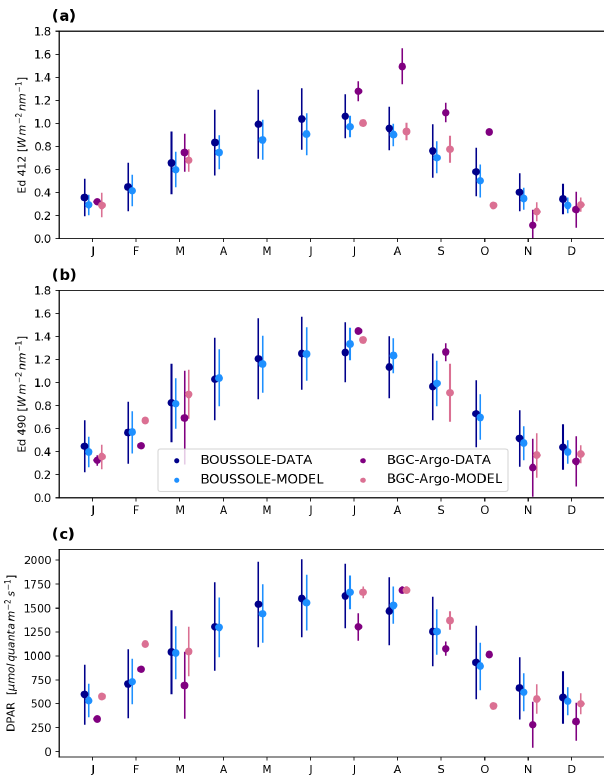
Figure 13. Scatter plots of the climatological monthly mean values and standard deviations of the downward ir- radiance E d (λ = 4124900 − ) (Wm − 2 nm − 1 ) and DPAR (µmolquantam − 2 s − 1 ). The blue dots represent the mean values of the measurements at the BOUSSOLE site and the corresponding model outputs, whereas the lilac points display the BGC-Argo values and model means, resulting from the match-up of all available profiles in the northwestern Mediterranean (NWM) sub-basin. Note that the points corresponding to each month are horizontally shifted to increase the